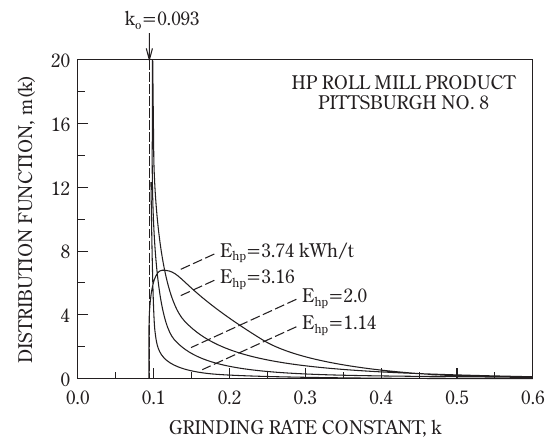
Fig. 11 Density functions for the distribution of the specific ball mill grinding rates of Pittsburgh No. 8 coal produced in the high-pressure roll mill at different energy inputs.